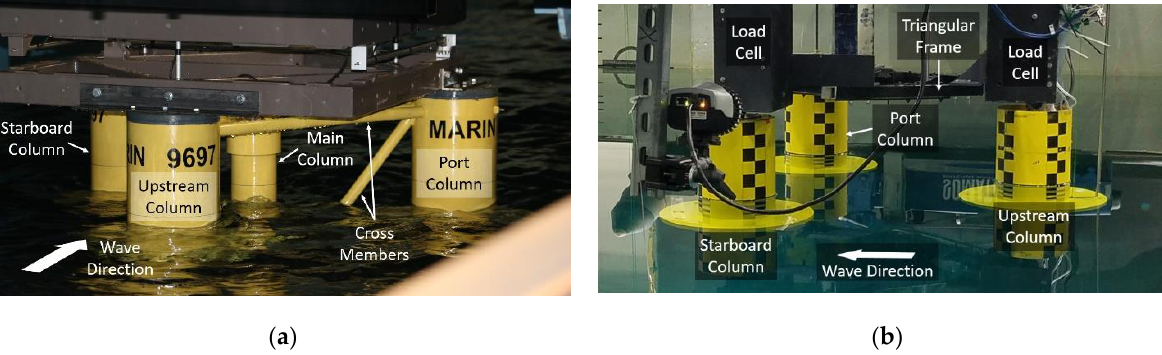
Figure 5. Comparison of the models of the semisubmersible floating wind substructure in the OC6 wave-basin experiments. ( a ) The DeepCwind platform used in the previous OC6 Phase Ia investigation [4]. This complete floater model includes the central main column and the cross-members connecting the columns. The same model geometry was also used in the previous OC5 full-system investigation [1]. Photo by Amy Robertson, NREL. ( b ) The simplified floater geometry without the central main column and the cross-members used in OC6 Phase Ib (present campaign). The three columns were independently mounted to a triangular frame above. This setup allows the wave loads on the upstream and starboard columns to be measured separately and concurrently using two load cells. A camera recording the wave run-up is visible to the left in ( b ). Photo adapted with permission from the University of Maine.